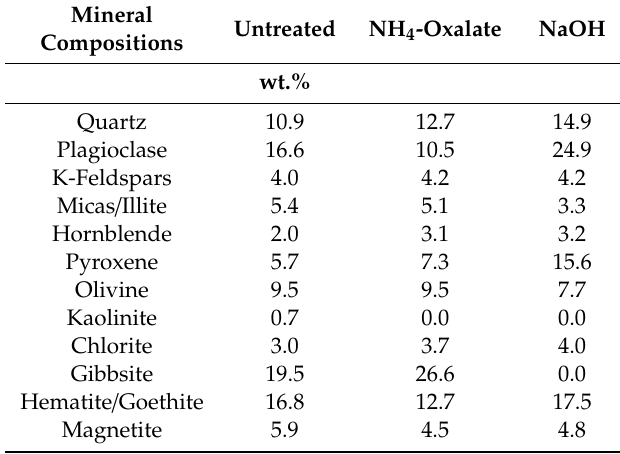
Table 5. X-ray di ff raction (XRD) semi-quantitative analysis after sequential extraction from the Bw horizon of Noro. Mineral Untreated NH 4 Compositions